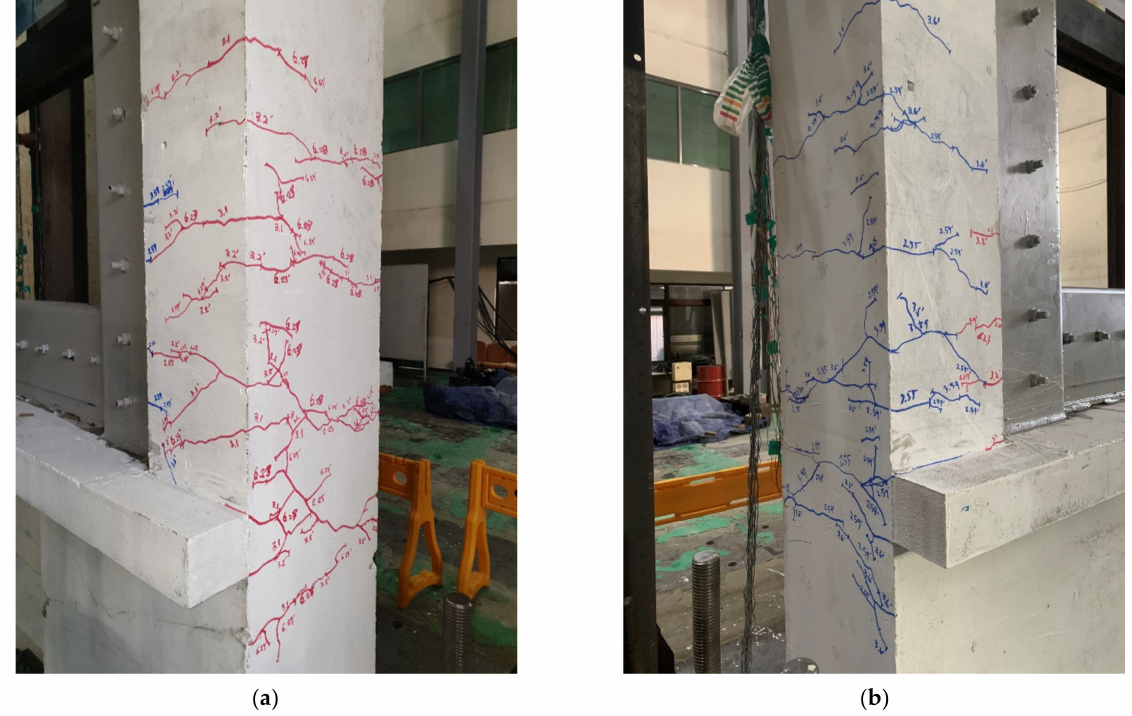
Figure 12. Cracks and ultimate state of test frame retrofitted with CFT-MF system (PD-CFT) (300 cm/s 2 ): ( a ) small shear cracks of the right column and ( b ) small shear cracks of the left column at the final